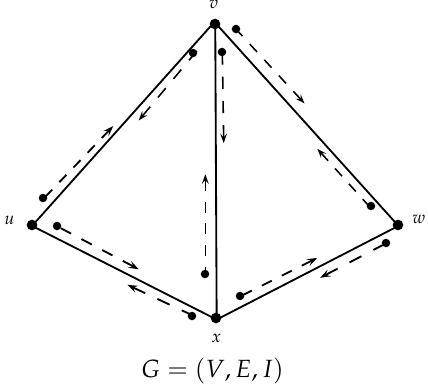
Figure 3. Incidence